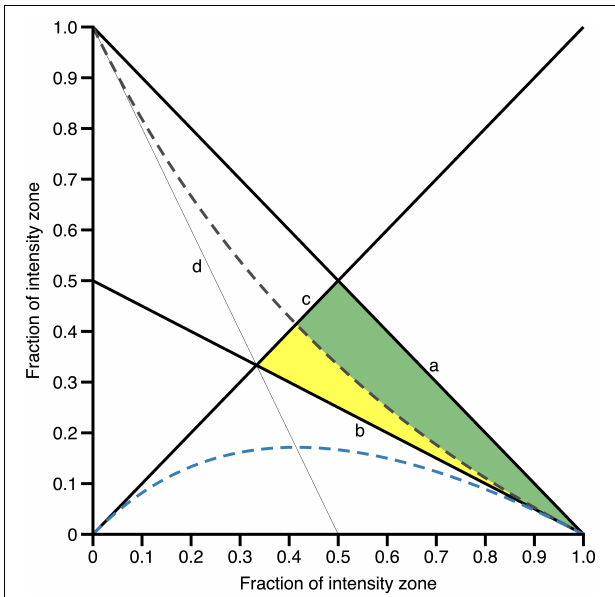
FIGURE 2 | Limits and conditions of the polarization index. Line a indicates the upper limit of Zone 3 for a given (x-axis) fraction of Zone 1 (condition a: Zone 1 + Zone 2 + Zone 3 = 1), line b indicates the lower limit of Zone 3 for a given fraction of Zone 1 (condition b: Zone 3 > Zone 2), line c indicates the upper limit of Zone 3 for a given fraction of Zone 1 (condition c: Zone 1 > Zone 3), and line d indicates the lower limit of Zone 3 for a given fraction of Zone 1 (condition d: Zone 1 > Zone 2). The colored areas represent the range of values where conditions a-d are fulfilled. The gray broken line indicates the limit of Zone 3 for a given fraction of Zone 1 resulting in a polarization-index of 2.00 a.U., i.e., if Zone 3 is higher or lower, polarization-index will result in values higher (green area) or lower than 2.00 a.U. (yellow area), respectively. The broken blue line indicates the upper limit of Zone 2 for a given fraction of Zone 1 to allow for a polarization-index ≥ 2.00